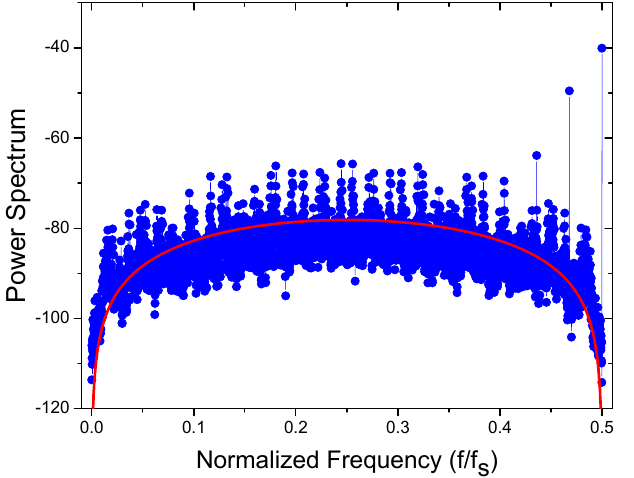
Figure 8. Power spectrum of the error signal from the behavioral simulation of the split-array C-DAC with the proposed switching scheme.